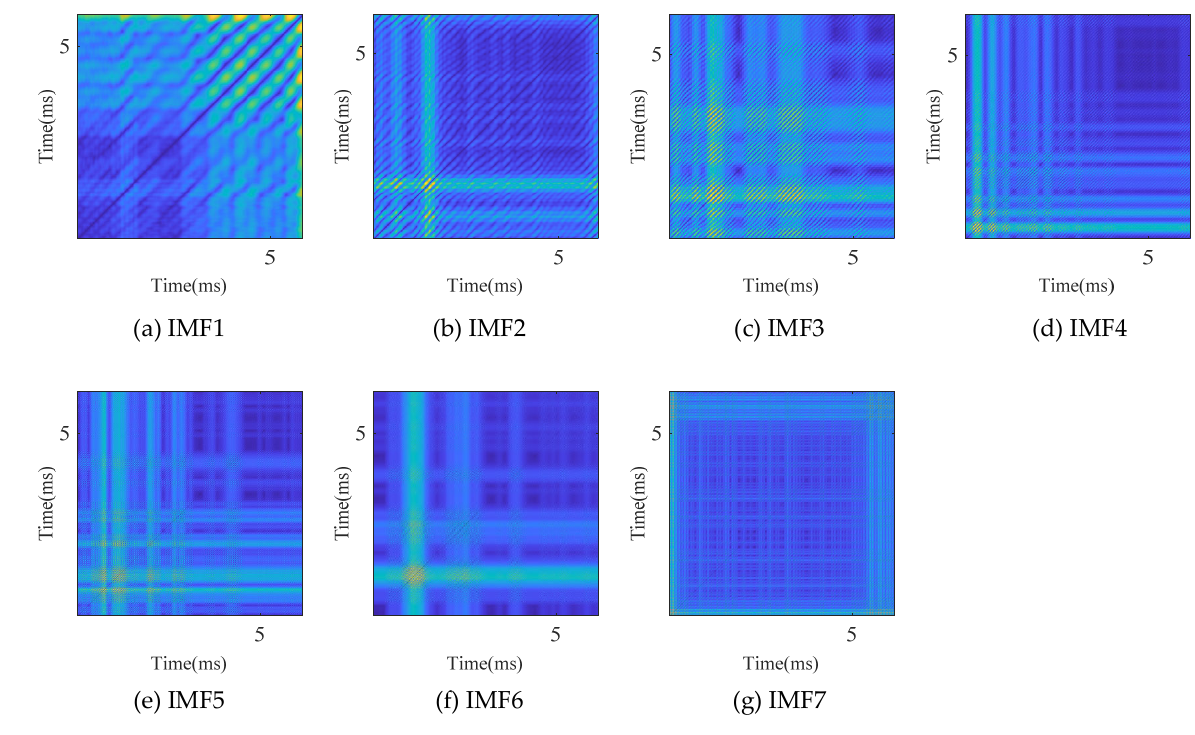
Figure 6. Recurrence plot images of the IMFs.